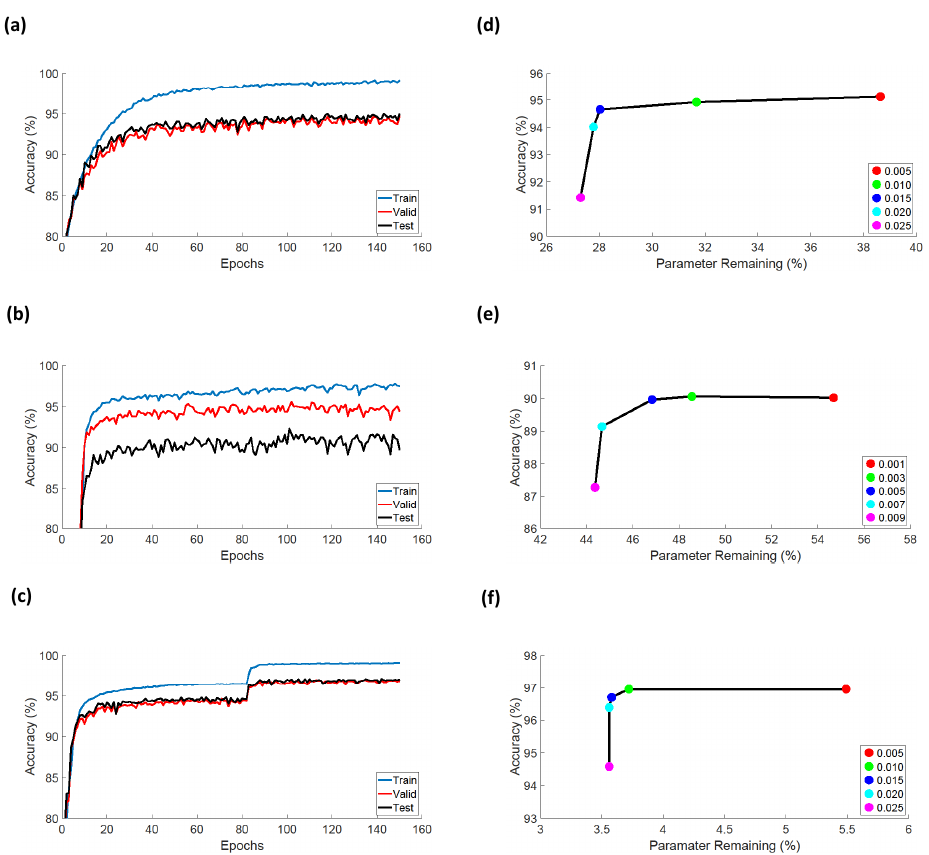
Figure A1. Impact of the different number of epochs ( a – c ) and prune thresholds ( d – f ) on the proposed (cid:96) 0 sparse group lasso approach on each HAR dataset—WISDM (a,d), UCI-HAR (b,e), and PAMAP2 (c,f),